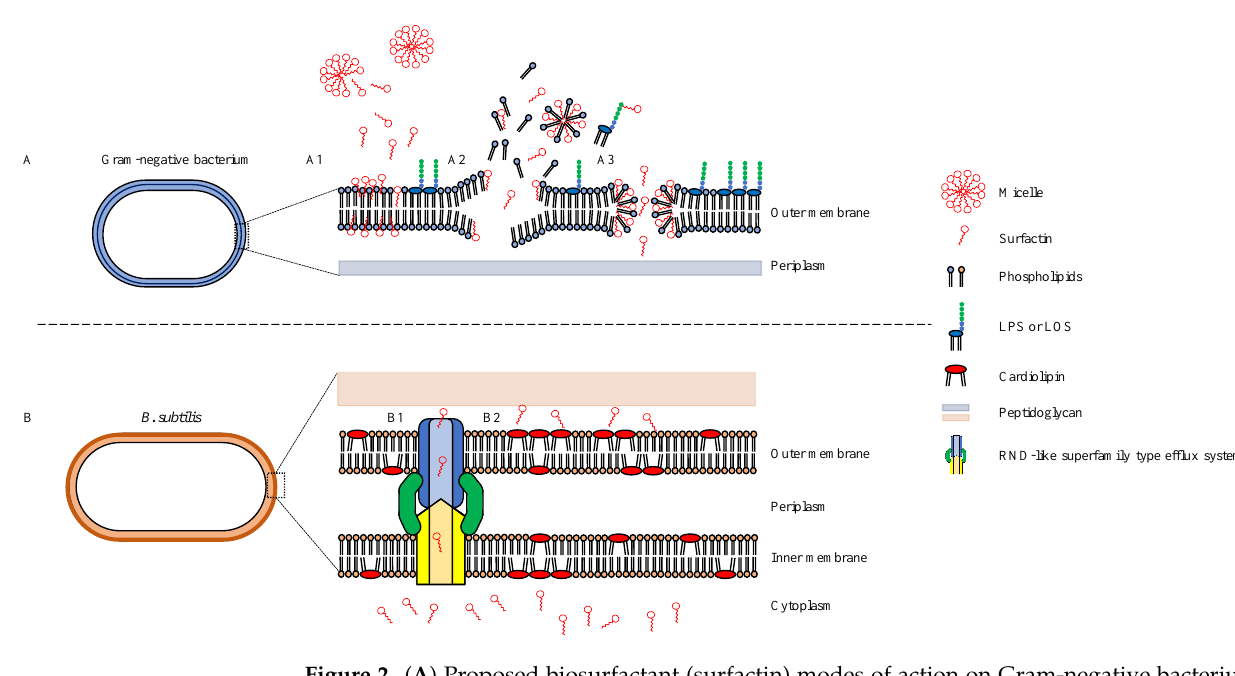
Figure 2. ( A ) Proposed biosurfactant (surfactin) modes of action on Gram-negative bacterium as indicated by (A1) insertion of biosurfactant fatty acid moiety, (A2) membrane disintegration, (A3) pore formation. ( B ) Surfactin resistance mechanisms described amongst B. subtilis strains; (B1) RND- like family efflux pump or other PMF dependant transporter and; (B2) Cardiolipin incorporation (adapted from Li et al. [12]; Balleza et al. [70]; Pinkas et al. [13]). LPS — Lipopolysaccharide; LOS — Lipooligosaccharide; RND — Resistance-nodulation-division.